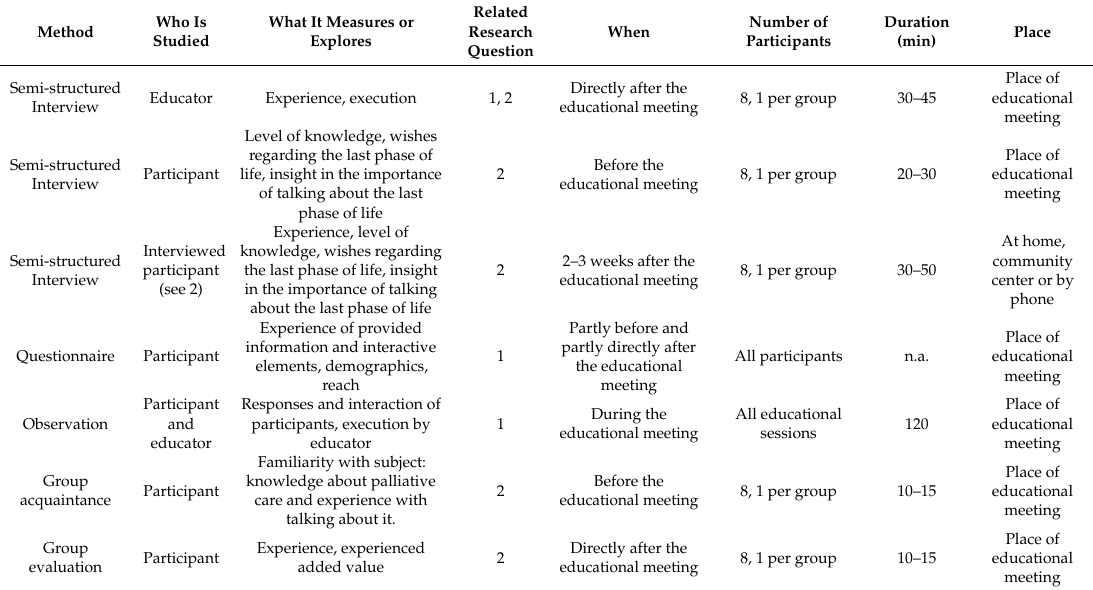
Table 1. Methods for